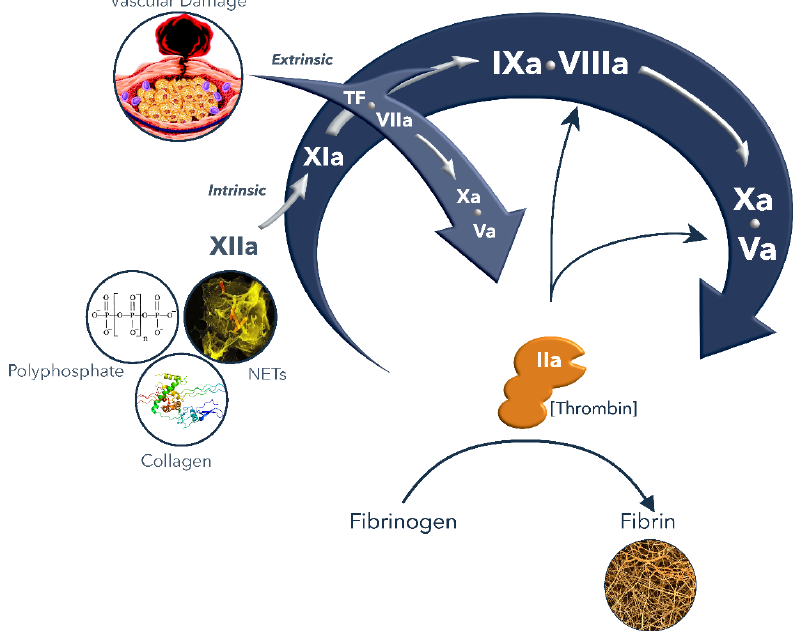
Figure 1. Highlight of the coagulation cascade (modified from